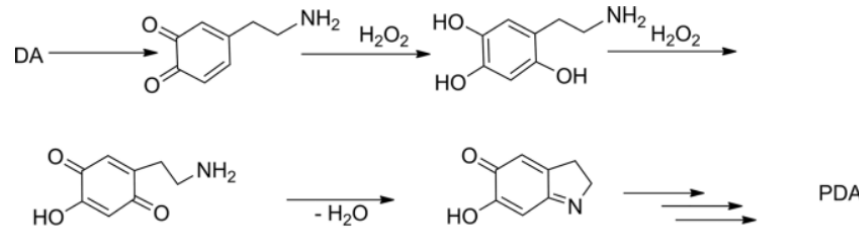
Figure 3. Oxidation of dopamine to polydopamine by hydrogen peroxide.